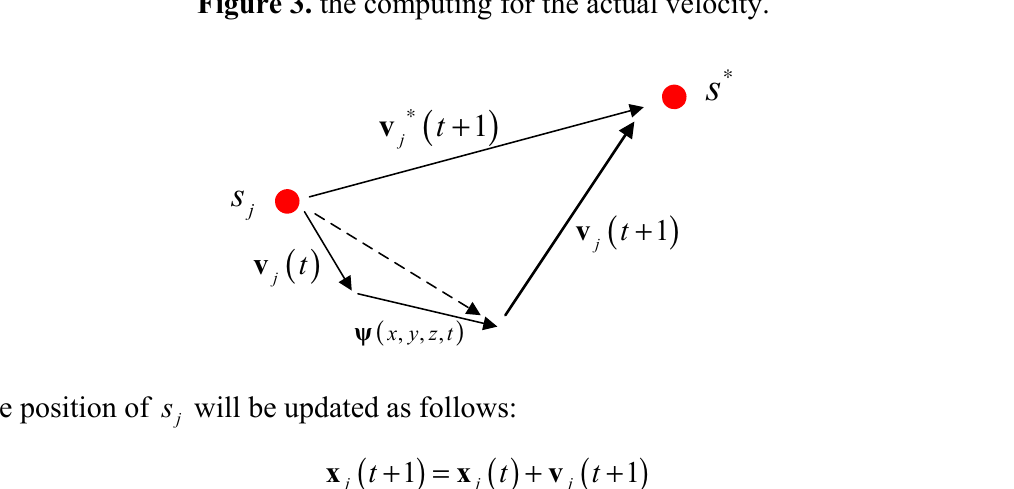
Figure 3. the computing for the actual